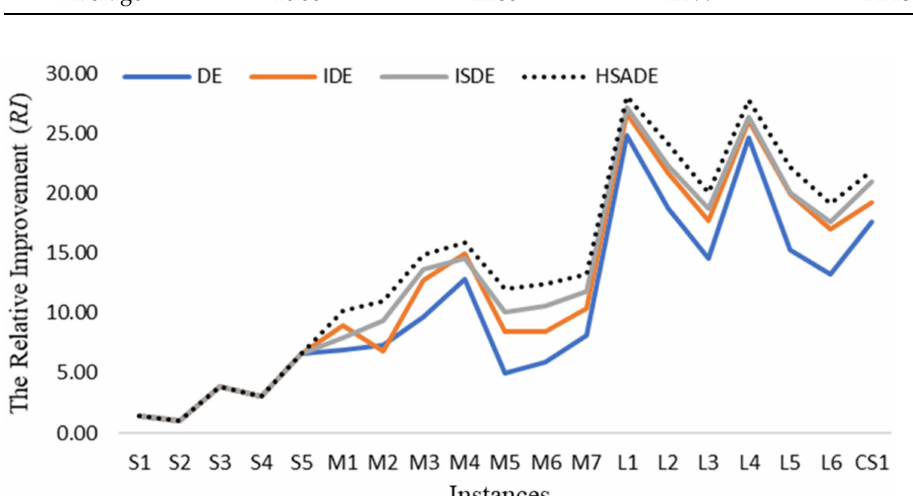
Figure 9. The relative improvement ( RI ) results for testing